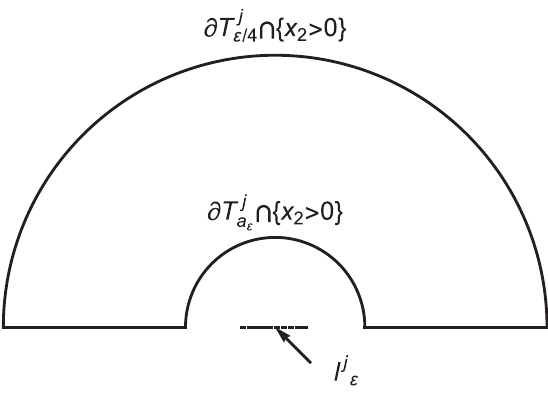
Figure 4: Domain T + , j ε \ T j a